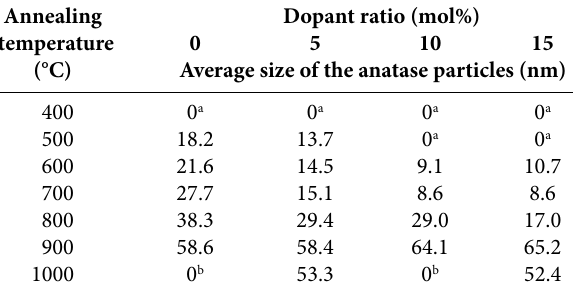
Table 2. Average size of the anatase particles in thin films with dif- ferent annealing temperatures and dopant ratios. Annealing